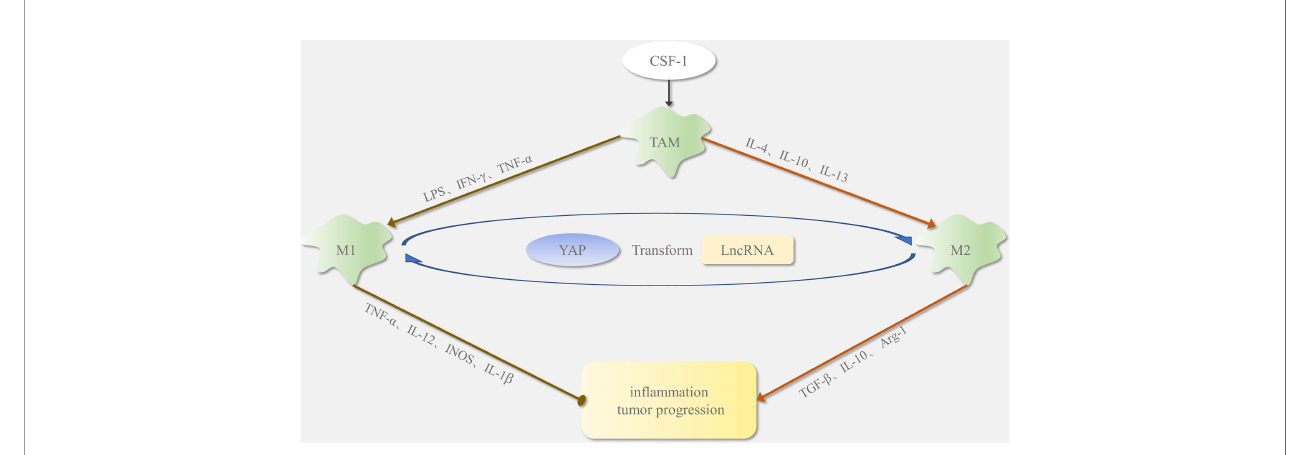
FIGURE 1 | Polarization of tumor-associated macrophages (TAMs): In the tumor microenvironment, macrophages are usually recruited by CSF1. In response to different signaling stimuli, macrophages polarize into M1 and M2 phenotypes. Factors such as LPS and IFN- g regulate TAM polarization toward the M1 type. The M1-phenotype macrophages secrete INOS, IL-1 b , and TNF- a as proin fl ammatory stimuli, which promote in fl ammatory responses and inhibit tumor growth. Factors such as IL-4 and IL-13 regulate TAM polarization toward the M2 type. The M2-phenotype macrophages release TGF- b , Arg-1, and IL-10, which inhibit the in fl ammatory response and promote tumor formation. Yap protein and lncRNA affect M1/M2 phenotypic transition.